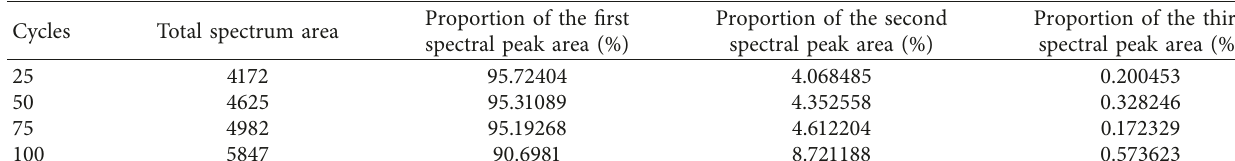
Table 5: Spectrum area of cement mortar specimens during freeze-thaw cycles.